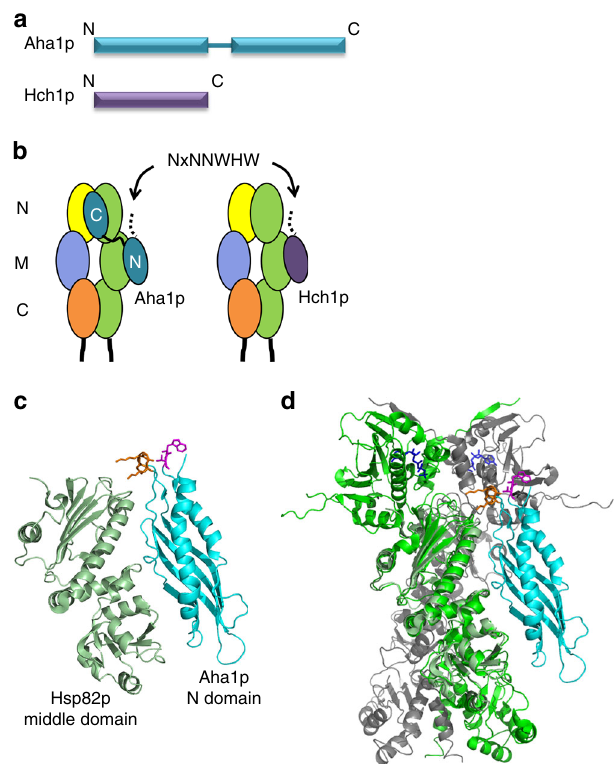
Fig. 2 Schematic of co-chaperones Aha1p and Hch1p and their interaction with Hsp90. a Hch1p corresponds to the N terminal domain of Aha1p which is connected to the C domain by a fl exible linker. b Hch1p and the Aha1p N domain interact with the middle domain of Hsp90. The Aha1p C domain interacts with the N terminal domains of Hsp90. c A model of the complex between the Hsp90 middle domain (light green) and the Aha1p N domain (cyan) (1USV 19 ). The RKxK motif is colored in orange and residues Trp11 and Val12 (magenta) indicate where the N terminal NxNNWHW motif would be present (it is unstructured in 1USV). d The structure shown in c is aligned to the full length, closed Hsp90 dimer structure (2CG9 33 ) with the two Sba1p subunits masked. ATP is depicted in blue wireframe. The NxNNWHW motif is predicted to be oriented towards the